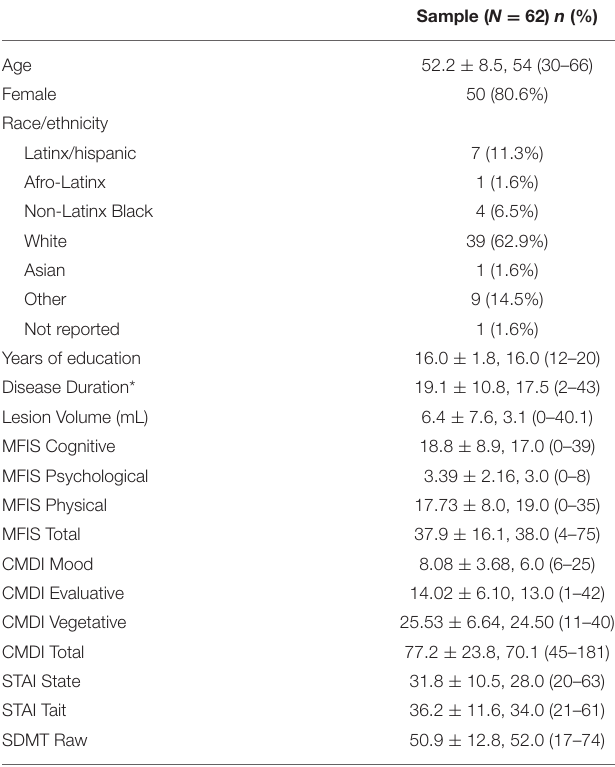
TABLE 1 | Descriptive characteristics of demographic and behavioral